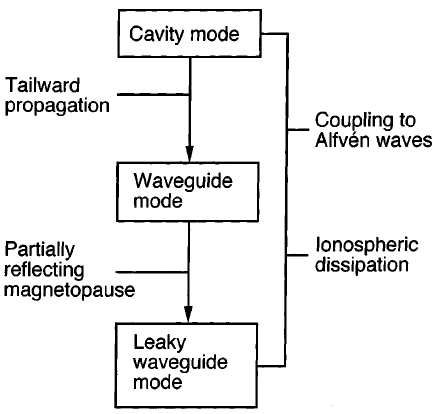
Fig. 1. Magnetospheric models used to study ULF wave propaga- tion. Various models with di(cid:128)erent geometries and energy loss mechanisms have been used in theoretical studies